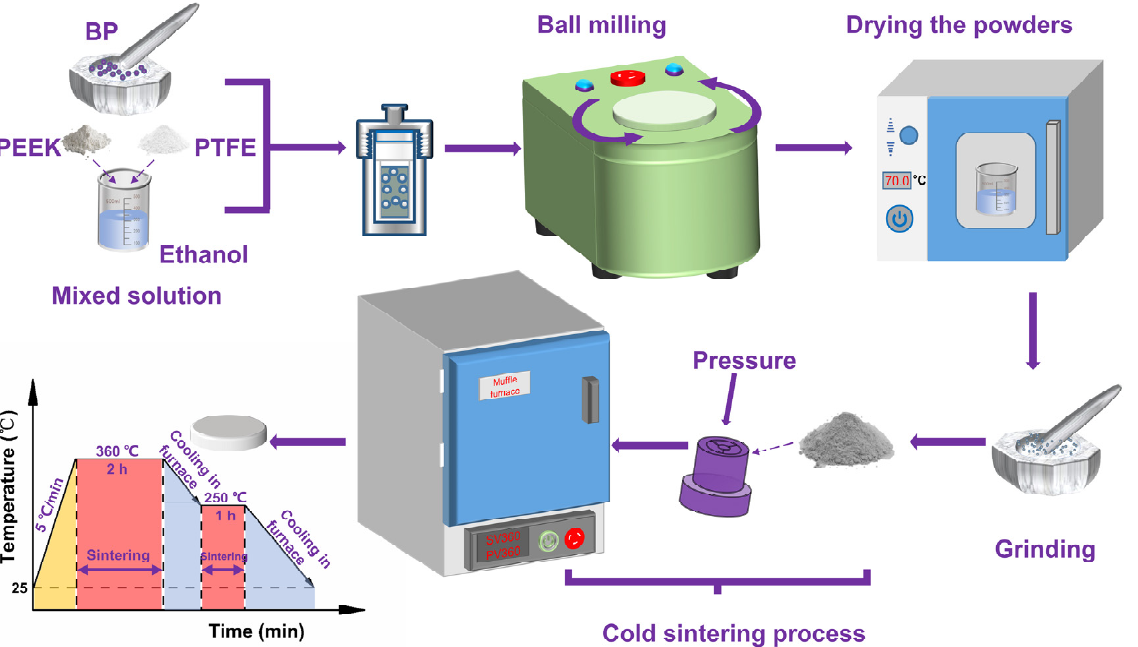
Figure 2. The schematic diagram of the preparation of PEEK/PTFE/BP composites through the cold sintering